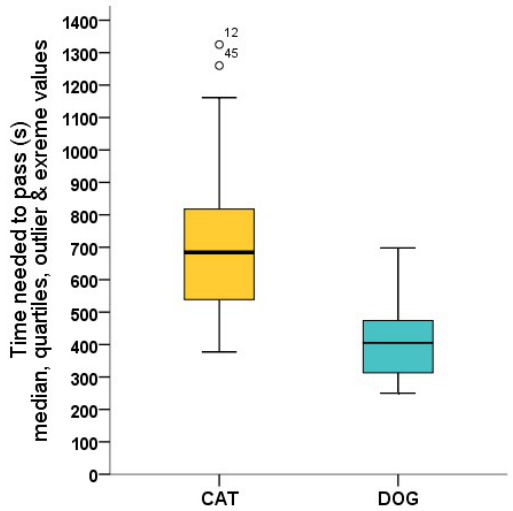
Figure 4. Time (s) needed to pass the test after the 5-min-long open field part. Only data of the cats successfully habituated on the first occasion were